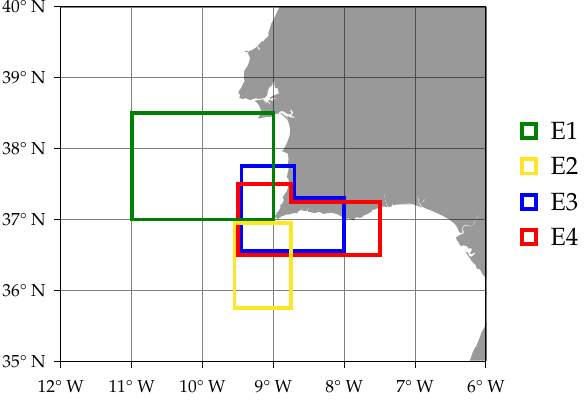
Figure 8. Map of the areas where an event of a certain type may occur.